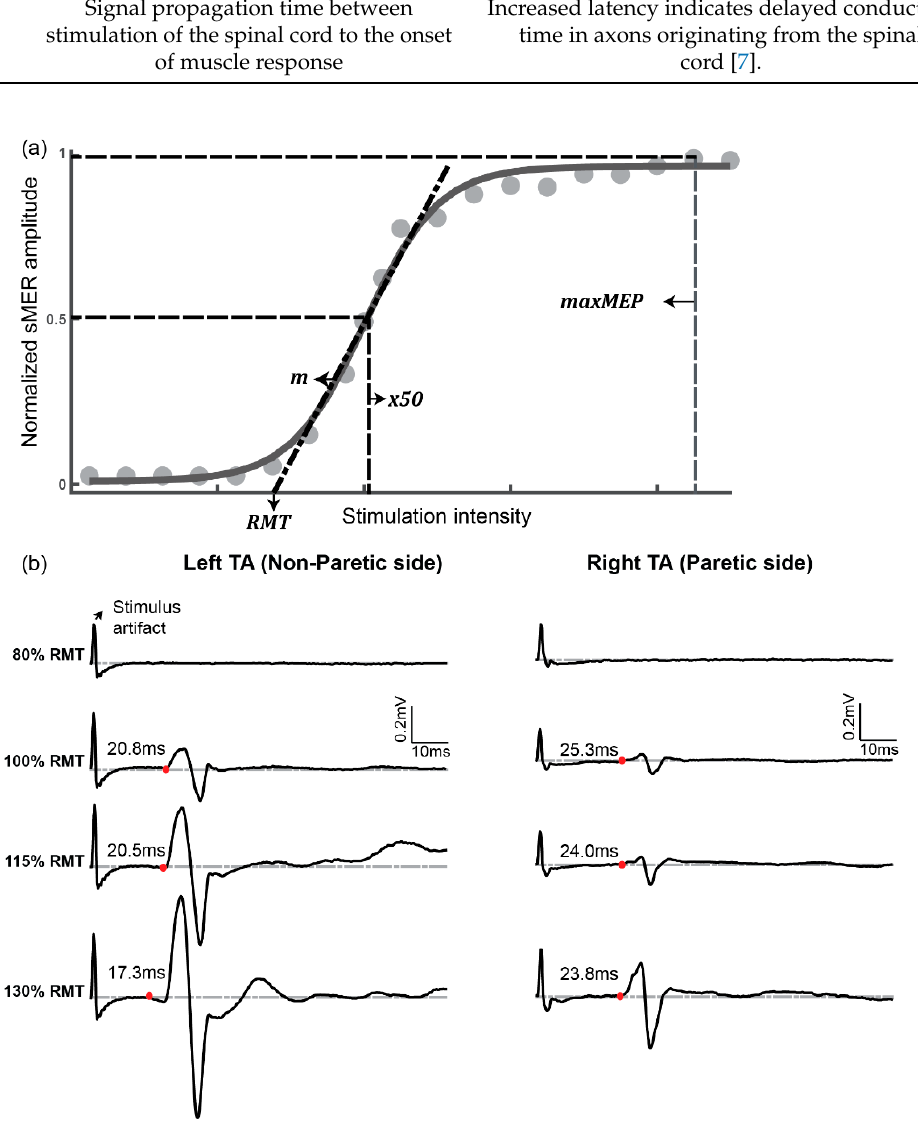
Figure 2. Representative spinal motor-evoked responses (sMERs). ( a ) The sMER recruitment curve for a single subject, based on peak-to-peak amplitude of averaged MER at each stimulation intensity. The points were fitted by a sigmoid function. Drop lines indicate the stimulator output at the resting motor threshold (RMT), x50, which is the stimulus intensity required to obtain an MER that is 50% of the maximum. ( b ) sMERs recorded across a range of responses evoked at different stimulation intensities expressed as a percentage of the RMT of a single subject. Latency was calculated as the time from the stimulation delivery to the first deflection of sMER data (red dot). To quantify the RMT and slope, the sMER recruitment plot was fitted to a sigmoid function using a custom script in MATLAB (Mathworks, Inc., Natick, MA, USA) [15,31]. The following four parameters were derived from the coefficients of the sigmoid fitting function (Equation (1)): (1) minMER , defined as the minimum value of the data; (2) max- MER , defined as the maximum value of the data; (3) x50, defined as the stimulation level